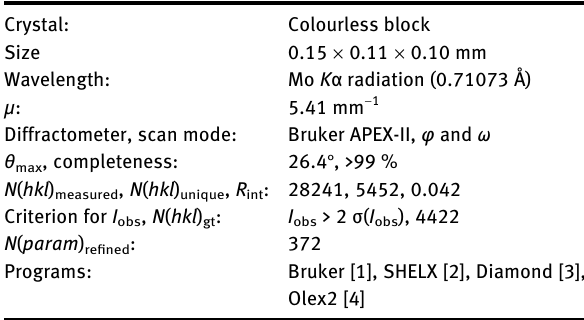
Table  : Data collection and